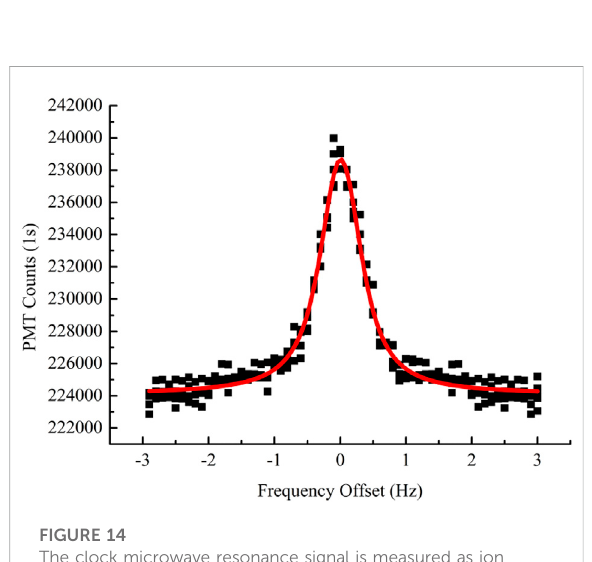
FIGURE 14 The clock microwave resonance signal is measured as ion fl uorescenceat194 nmvs.microwavefrequencyappliedtoionsin the 4-pole trap. The center frequency is about 40.507348 GHz.